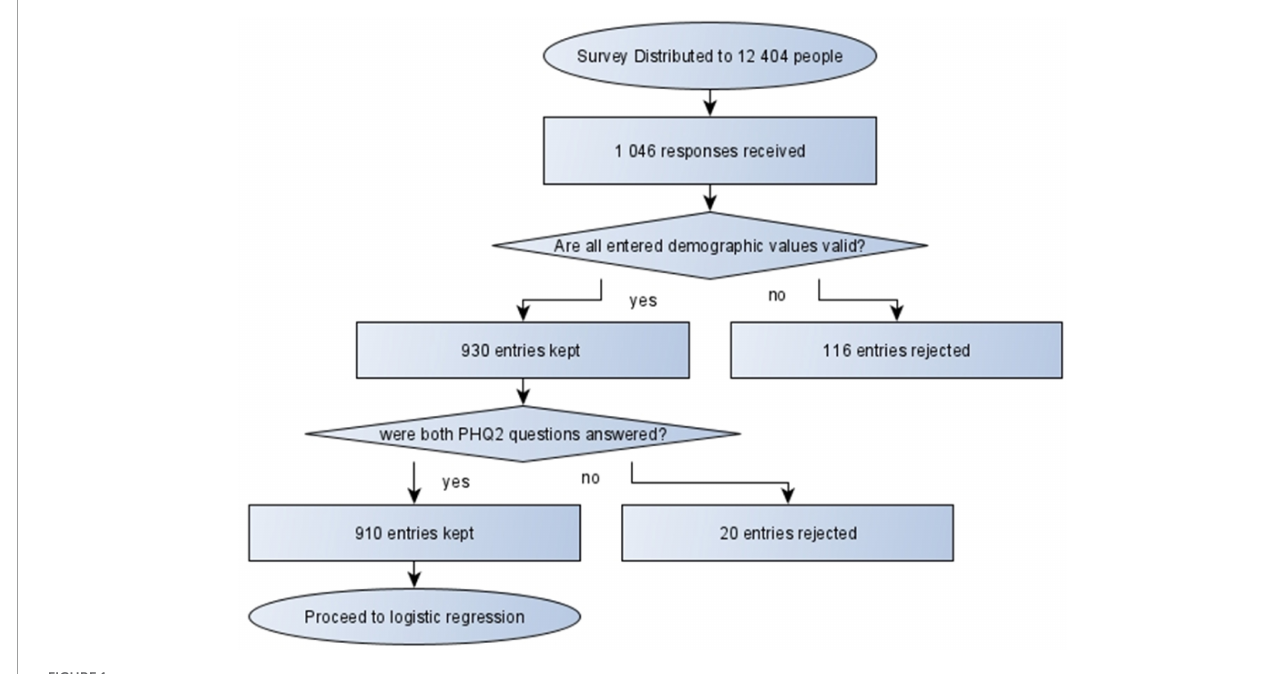
FIGURE1 Flow of data collection through the